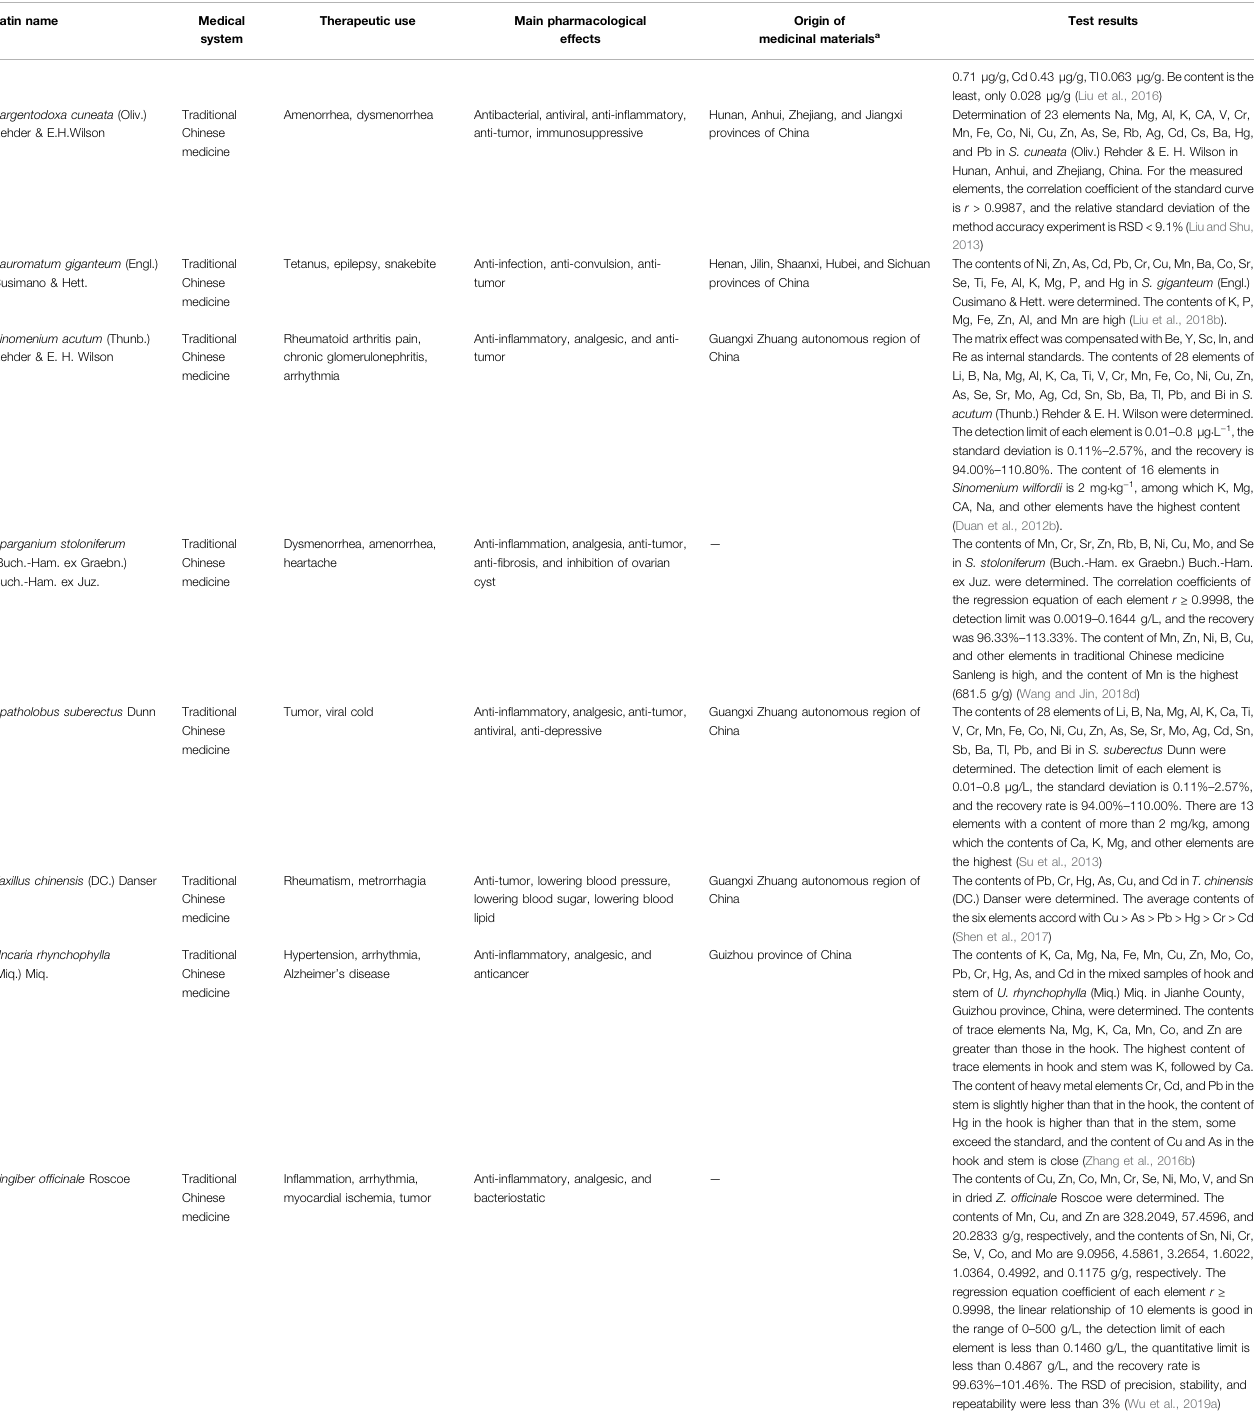
TABLE 2 | ( Continued ) Application of ICP-MS in the determination of heavy metals in medicinal materials derived from the stem of